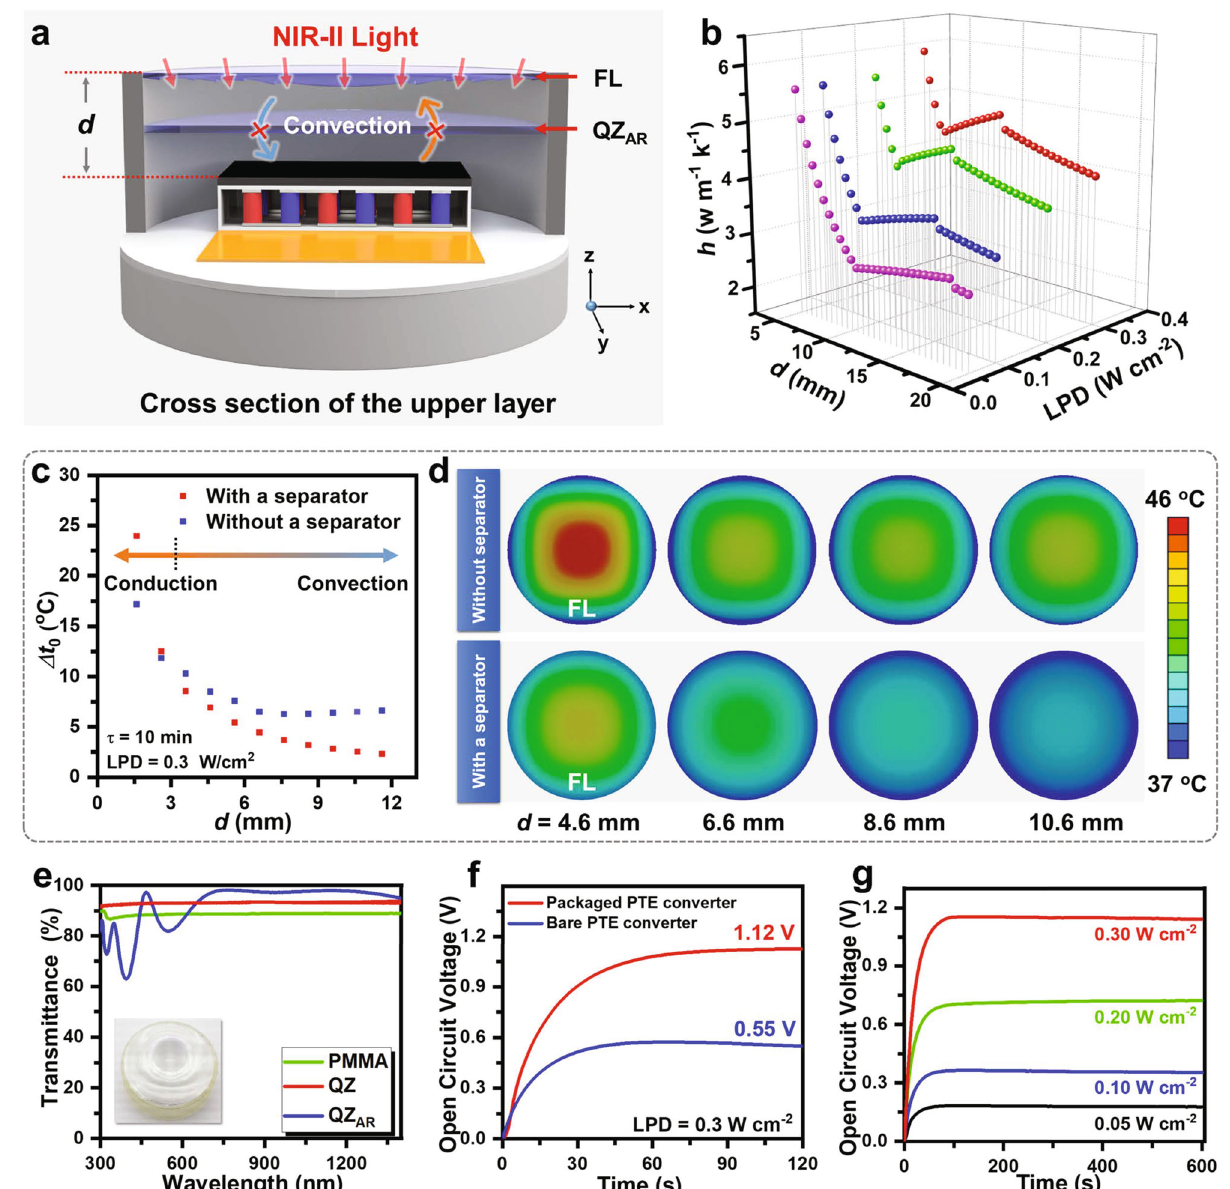
Fig. 3 | The design and characterization of the upper layer. a Schematic of the cross-sectionoftheupperlayer,fromtoptobottom,includingaFresnellens,anair layer separated by a transparent quartz plate with antire fl ection coatings, PT layer on the topofa TEgenerator.The entire PTEconverter isenclosedbya polymethyl methacrylate shell. b The estimation of convective heat transfer coef fi cient in the presenceofanairlayerwithdifferent d betweenPTlayerandFresnellens,orunder NIR-II light irradiation with different LPDs. c The investigation of the effect of the separatorinsertedintheairlayerwithdifferent d ,byrecording Δ t 0 relativetobody temperature (37°C) under NIR-II irradiation with LPD of 0.3Wcm − 2 for 10min. d The predicted temperature distribution on the Fresnel lens which is the top